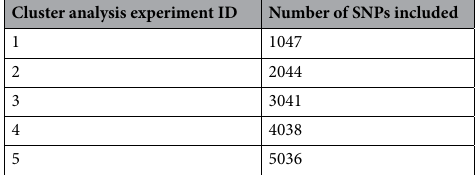
Table 1. Number of SNPs subjected to cluster